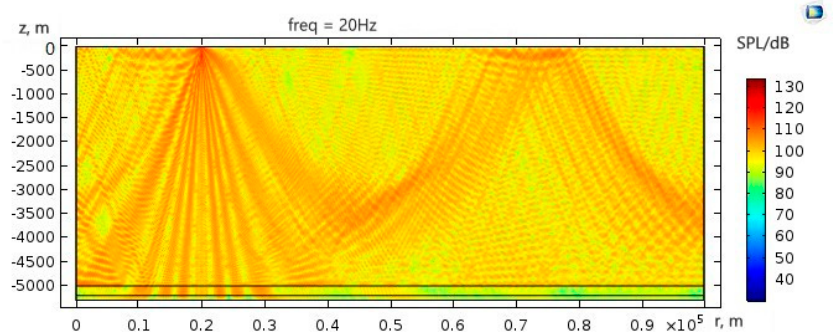
Figure 13. Sound pressure level distribution when the sound source is located at the center of the vortex (DC = − 20 m/s).